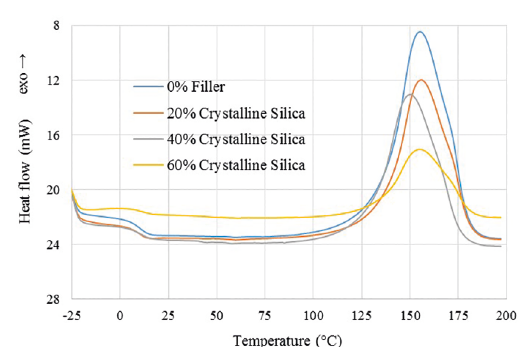
Figure 6. DSC of the composites prepared with 20, 40, and 60% (wt) crystalline silica